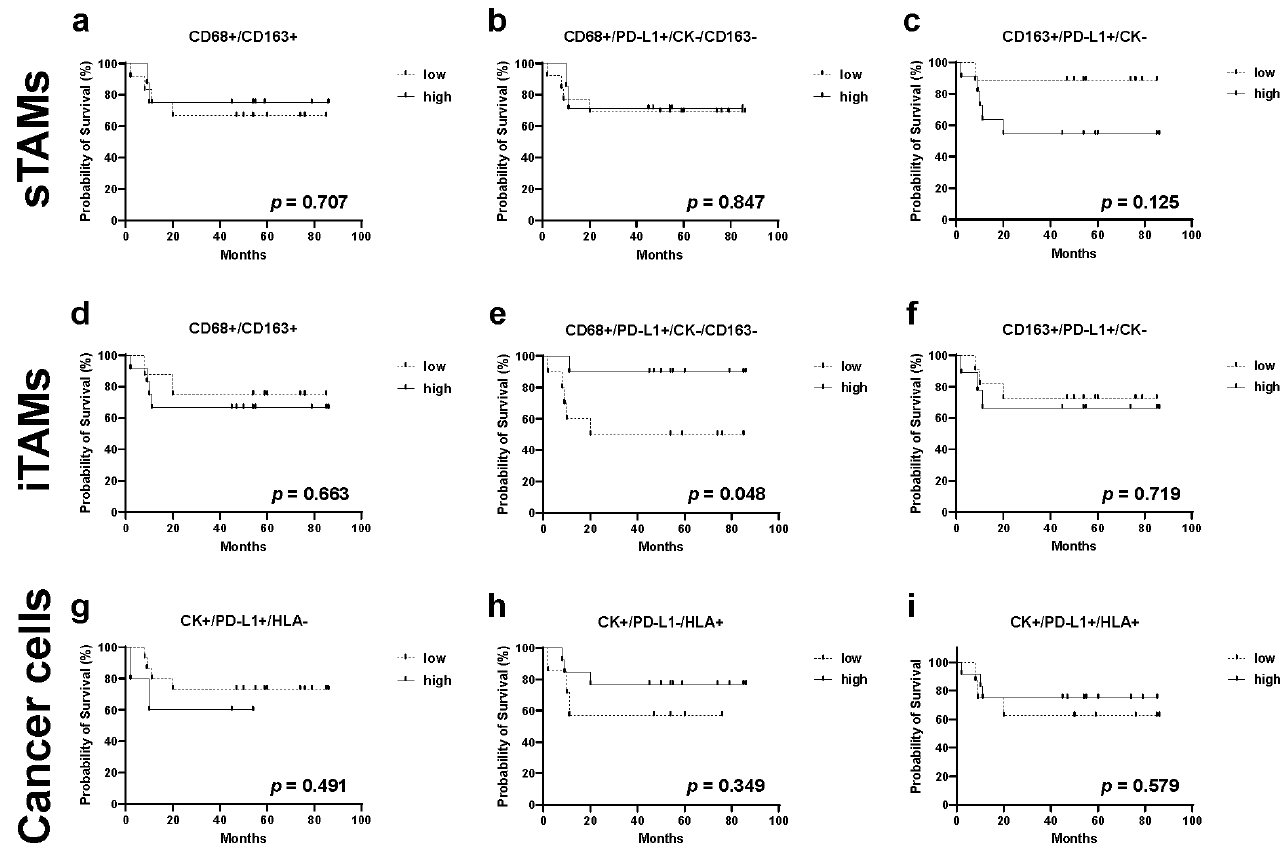
Figure 6. Kaplan–Meier analysis for recurrence-free survival categorized by the number of TAMs (sTAMs and iTAMs), immune modification, and B-cell and cancer cell markers in triple-negative cases. Each subpopulation combining markers of TAMs, B-cells, and cancer cells was classified into “low” or “high”: ( a ) CD68+/CD163+ sTAMs low, <280 cells; high, ≥ 280 cells; ( b ) CD68+/PD-L1+/CK-/CD163- sTAMs low, <3 cells; high, ≥ 3 cells; ( c ) CD163+/PD-L1+/CK- sTAMs low, <50 cells; high, ≥ 50 cells; ( d ) CD68+/CD163+ iTAMs low, <25 cells; high, ≥ 25 cells; ( e ) CD68+/PD-L1+/CK-/CD163- iTAMs low, <1 cells; high, ≥1 cells ( p = 0.048); ( f ) CD163+/PD-L1+/CK- iTAMs low, <10 cells; high, ≥10 cells;